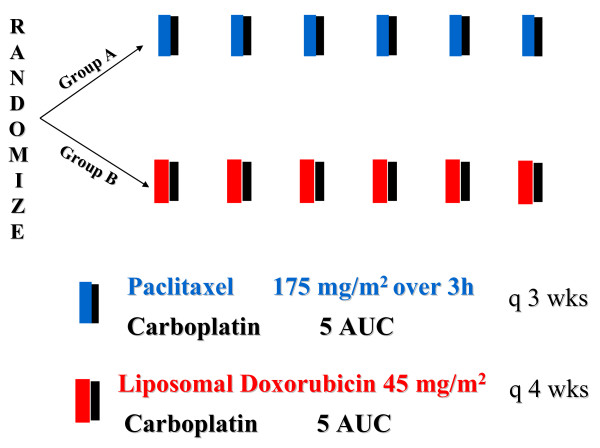
Treatment schema.